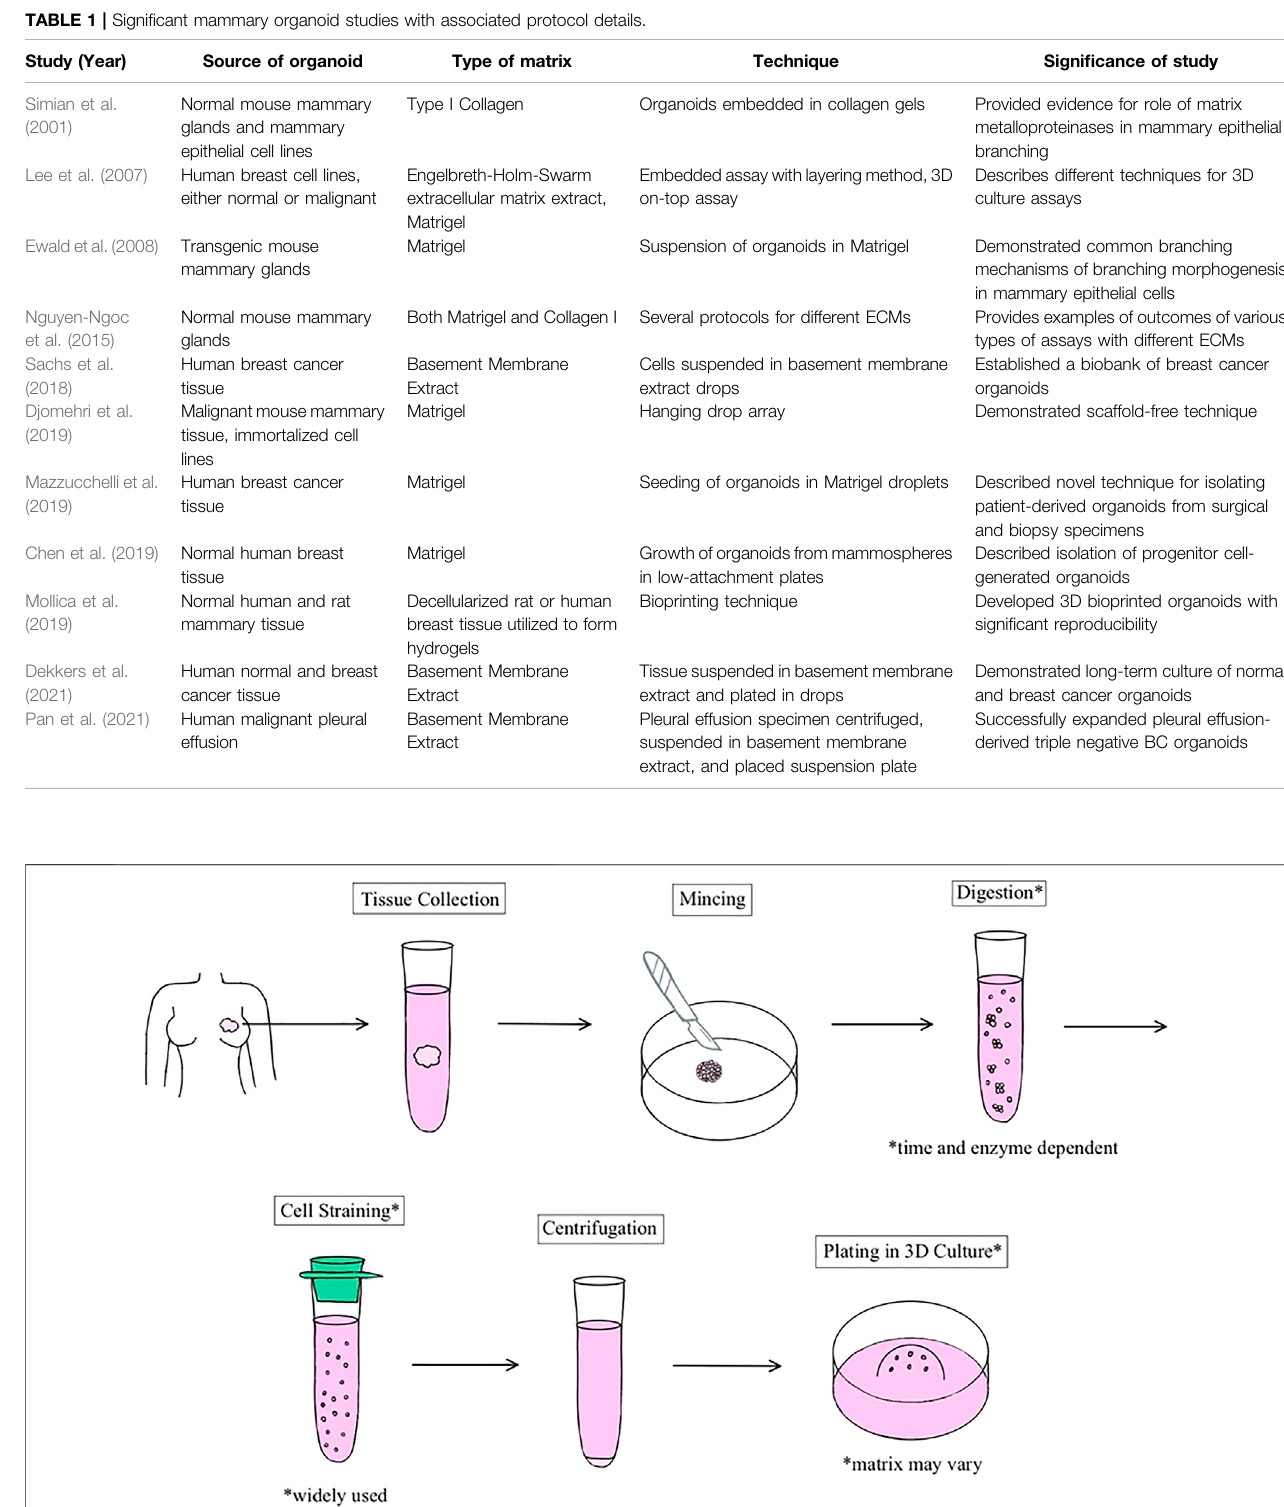
Frontiers in Bioengineering and Biotechnology |